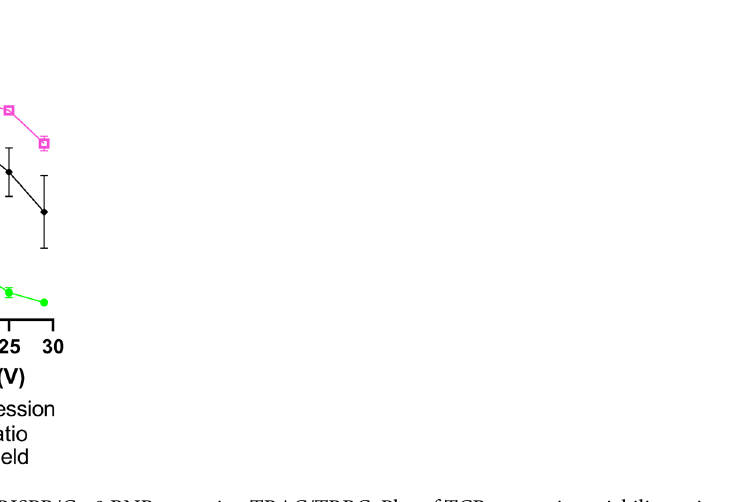
Figure 7. Delivery of CRISPR/Cas9 RNPs targeting TRAC/TRBC. Plot of TCR expression, viability ratio, or relative yield as a function of applied voltage amplitude, measured 72-h after primary T cells were